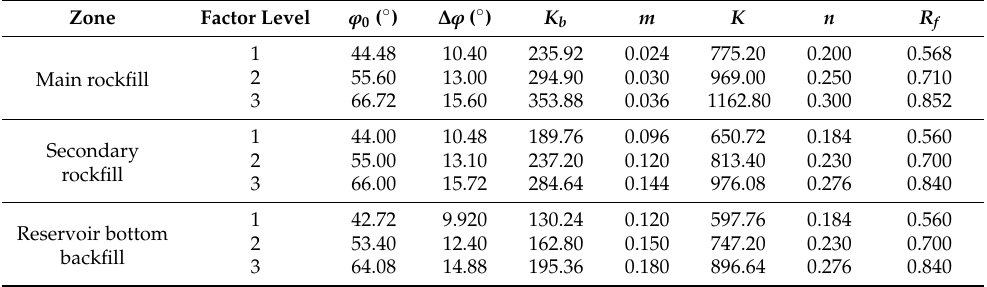
Table 4. Factor levels for orthogonal